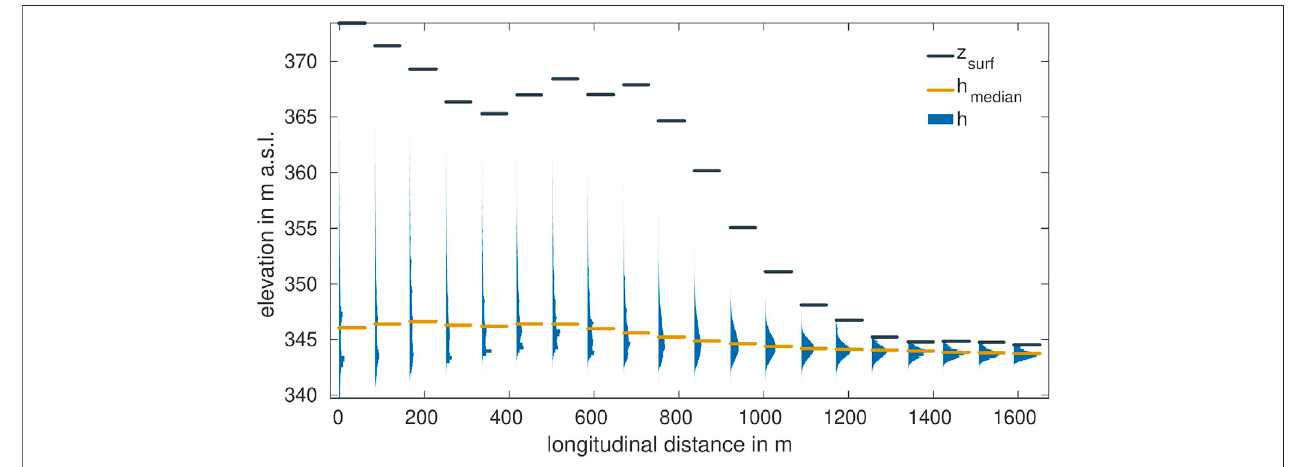
FIGURE 6 | Distributions of virtual hydraulic-head observations using the sample of stage-2-accepted realizations at all twenty potential locations along the transect.